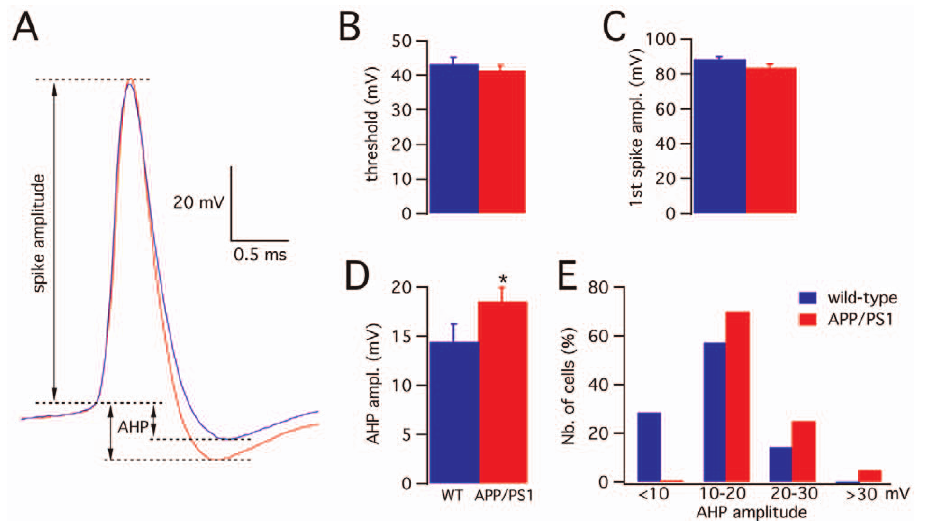
Figure 3. Evoked action potential properties. ( A ) Superimposed traces of first action potentials of wild-type (blue) and APP/PS1 (red) PCs. The horizontal dotted lines represent the threshold and the negative peaks reached by the afterhyperpolarization (AHP). The vertical arrows indicate the measurements of spike amplitude (for both wild type and APP/PS1) and of the AHP (separately for wild-type and APP/PS1). ( B ) Mean action potential threshold (P . 0.05). ( C ) Mean amplitude of the first spike (P . 0.05). ( D ) Mean AHP amplitude in wild-type (n=14) and APP/PS1 PCs (n=20). The difference is statistically significant (*: p , 0.05, t test). ( E ) Histogram of AHP sizes divided in four groups ( , 10, 10–20, 20–30, . 30 mV). Note the shift to the right of the distribution in APP/PS1